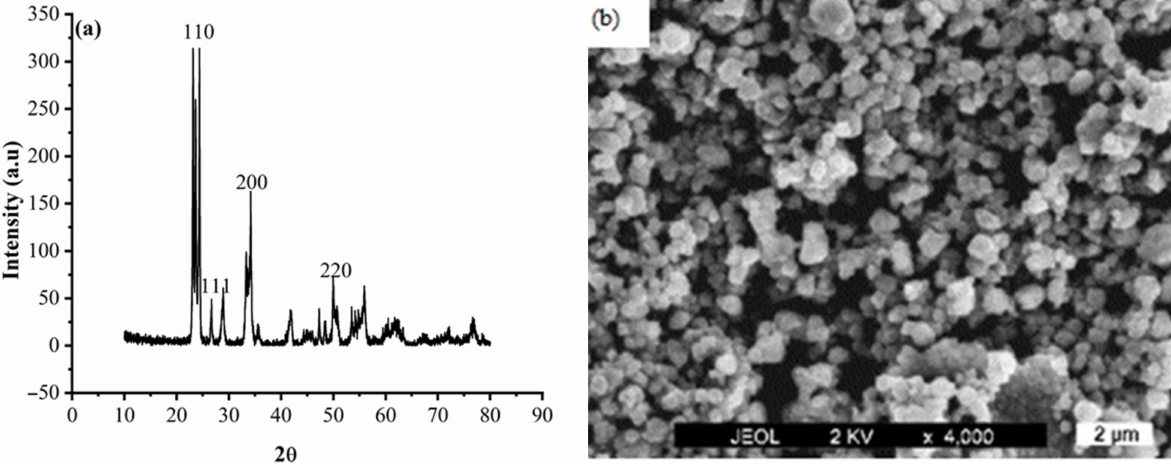
Figure 2. WO 3 particles of ( a ) XRD pattern and ( b )